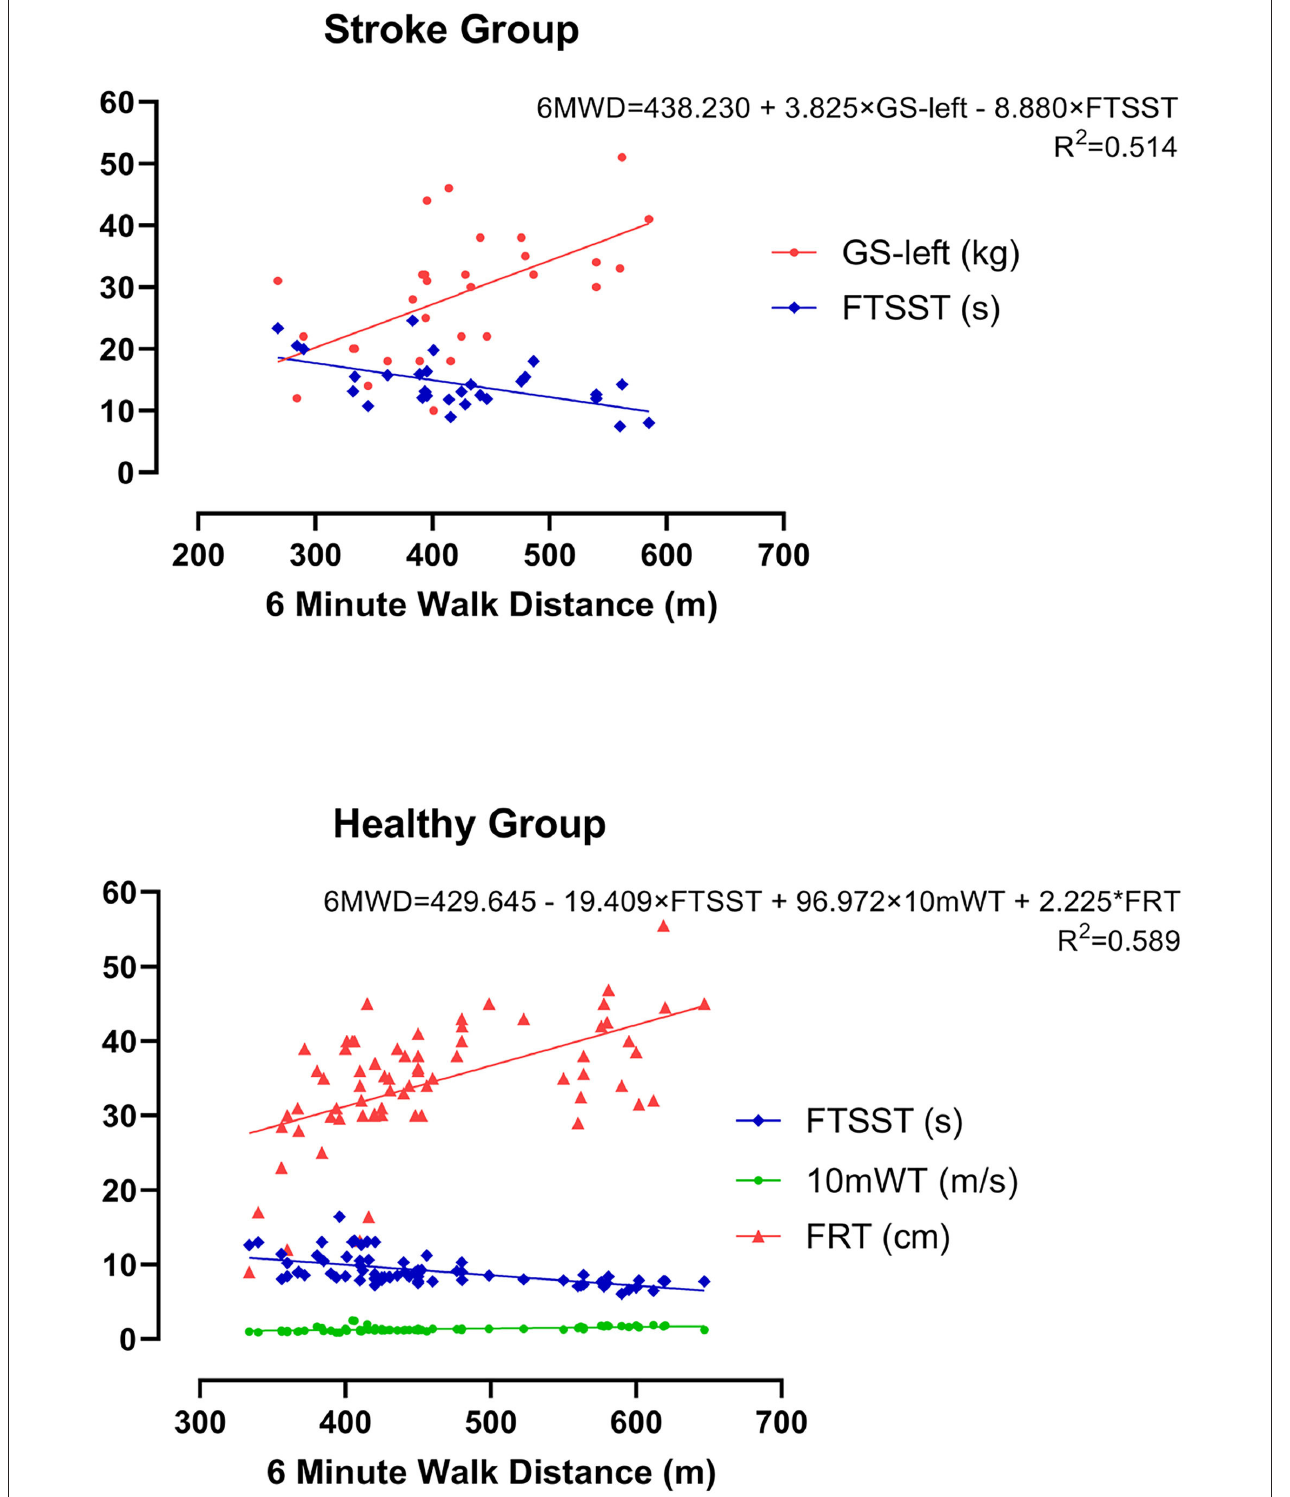
FIGURE 2 | Correlation matrix of the stroke group. NIHSS, National Institutes of Health Stroke Scale; MRS, modified Rankin Scale; GS, grip strength; BMI, body mass index; FTSST, five-times sit-to-stand test; FRT, functional reaching test; BBS, Berg Balance Scale; 10mWT, 10-m walk test; 6MWD, 6-min walk distance.